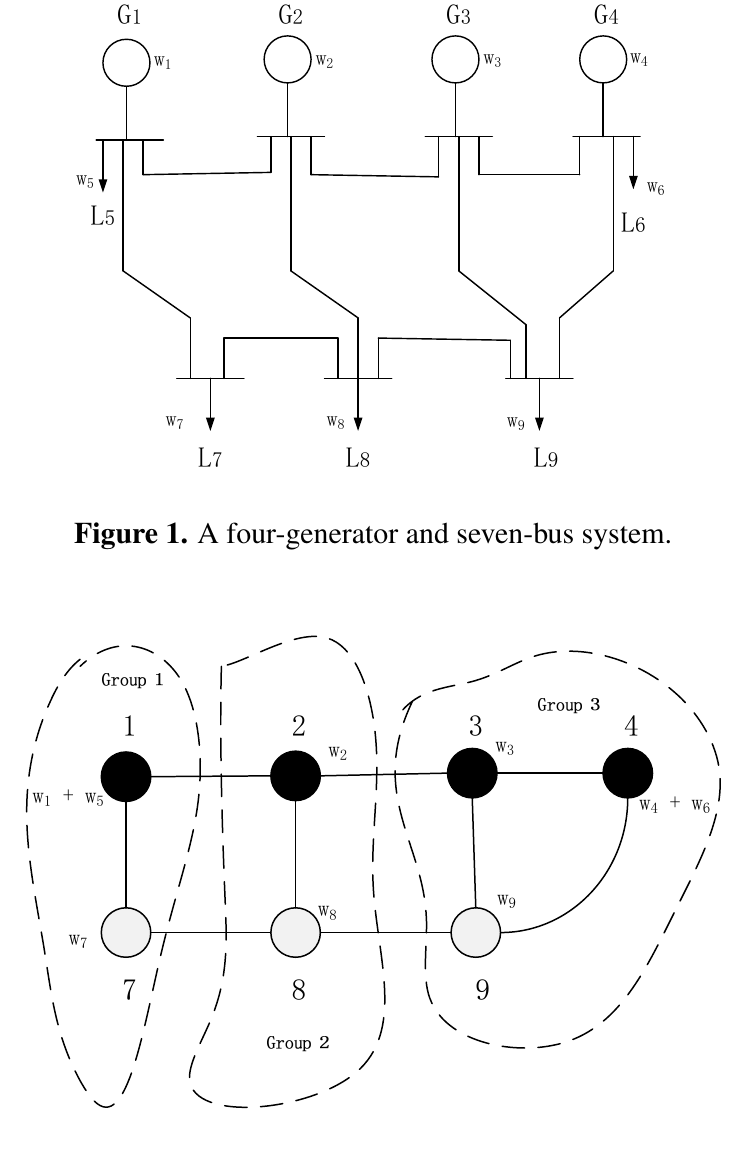
Figure 2. The topological graph of the 4-generator and 7-bus